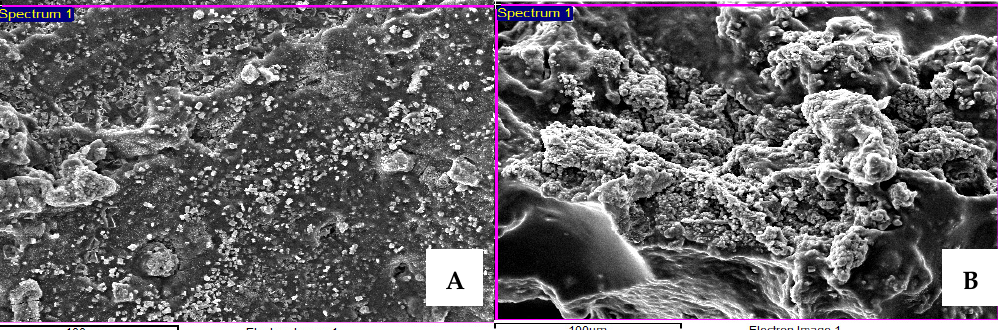
Figure 5. The scanning electron microscopy (SEM) images of nanohydroxyapatite-based hydrogel before and after immersion with simulated body fluid (SBF) for 14 days. ( A ) The image shows the distribution of hydroxyapatite composition within hydrogel. ( B ) The image shows new apatite formation at day 14 of SBF immersion.